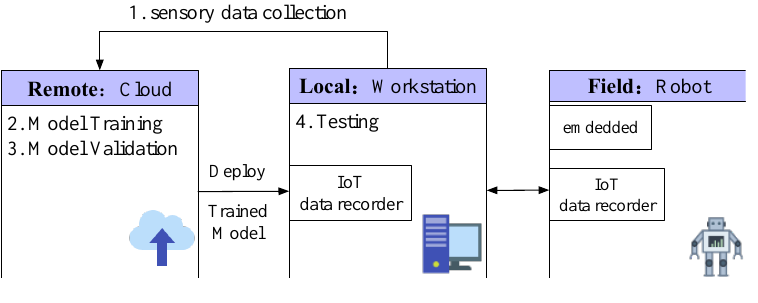
Figure 3. AIoT architecture.